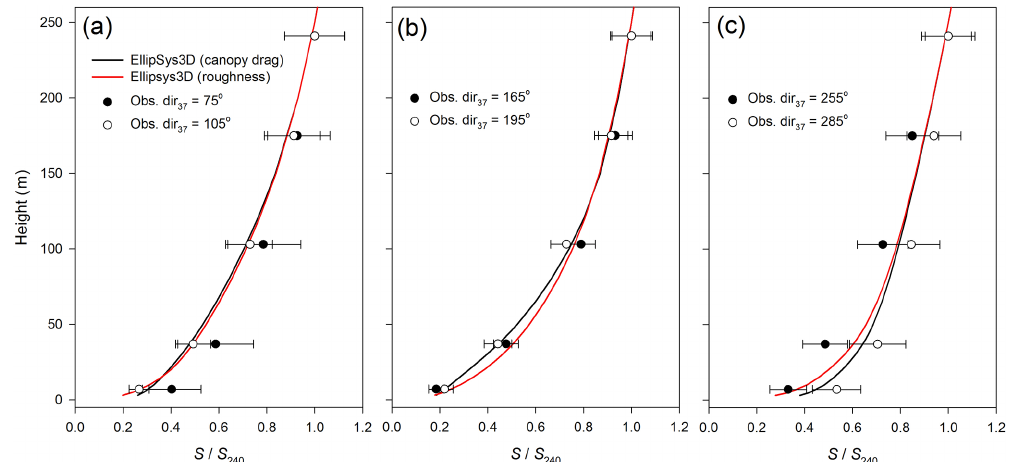
Figure 4. Normalized observed (circles) and modelled (lines) wind speed profiles at the mast position in Østerild site for different wind directional sectors around (a) 70 ◦ , (b) 180 ◦ and (c) 270 ◦ . Modelled results plotted for the case with a full description of canopy drag forces (black) and the case with forest replaced by the effective roughness (red). Bars denote standard deviations normalized on S 240 .